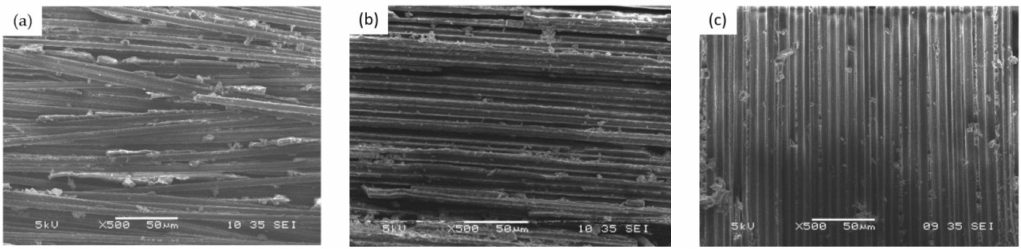
Figure 12. ENF test microfracture of composite (500 × ). ( a ) 26.6% CF, ( b ) 64.9% CF, ( c ) 76.4%